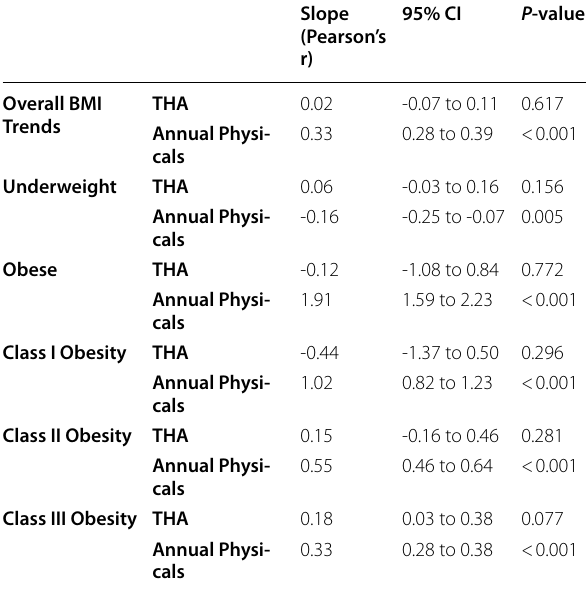
Table 3 Significance of